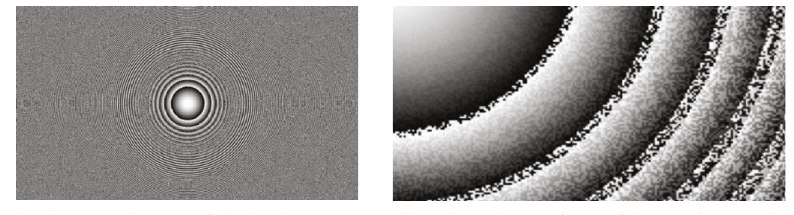
Figure 2: SLM loaded bit-phase mask.